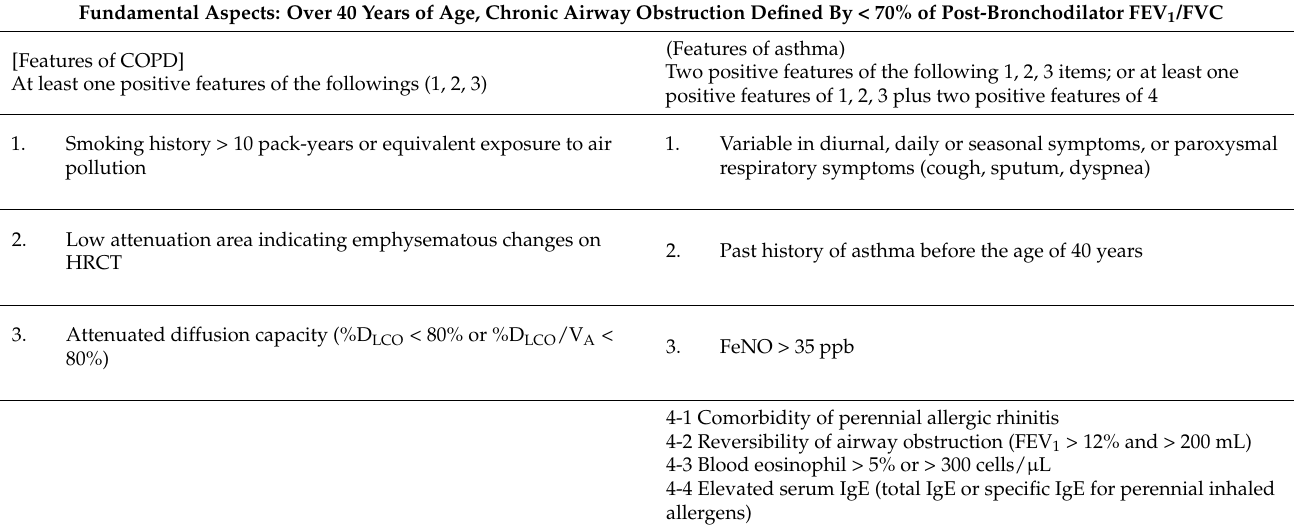
Table 2. Diagnostic criteria for ACO issued by the Japanese Respiratory Society